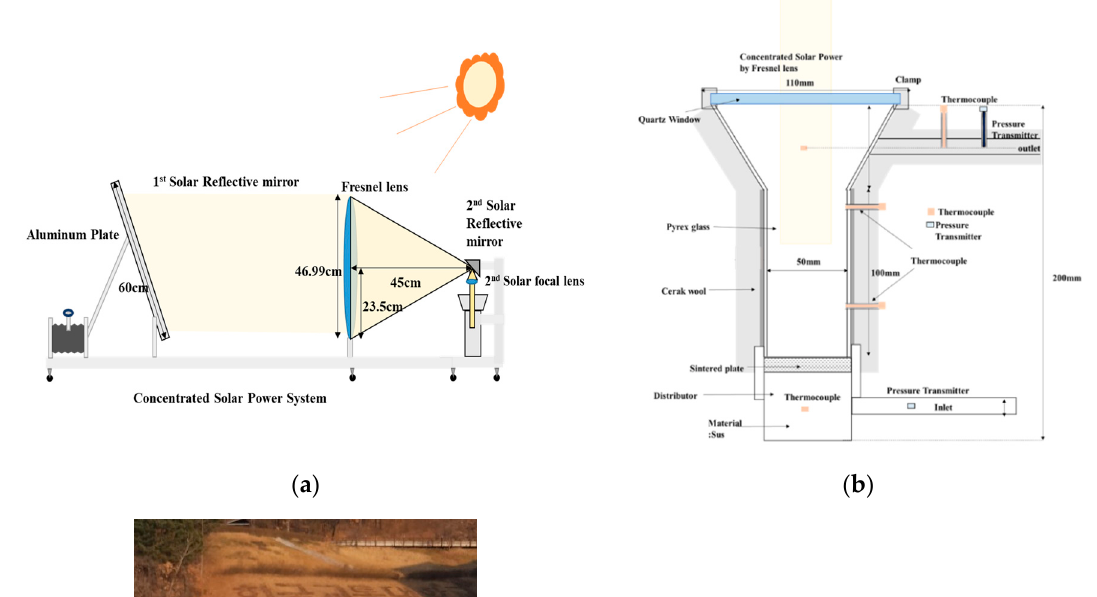
Table 1. Physical properties of SiC (Silicon carbide) particles used in the study.